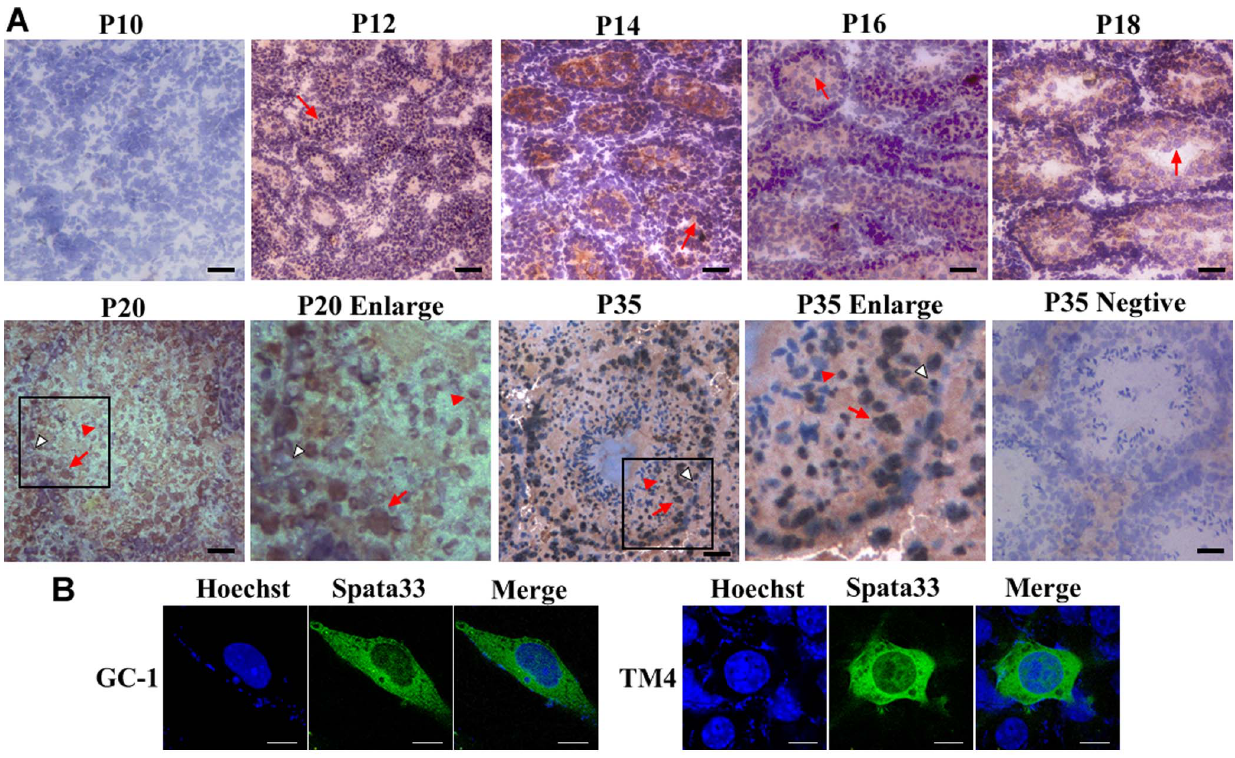
Figure 5. Immunostaining of Spata33 protein in the juvenile (aged 10–20 days) and mature testes (aged 35 days) using anti- Spata33 antibody (A), and subcellular localization of Spata33 protein in the GC-1 cells and TM4 cells (B). A). Spata33 was expressed mainly in the spermatogonia (white arrow heads), spermatocytes (red arrows) and round spermatids (red arrow heads). The signals were observed in both the cytosol and nuclei from P12-P35, whereas no signals were detected in P10. In controls, no positive signals were observed in P35 testis sections when Spata33 antibody was replaced by 1% normal rabbit serum. Nuclei were re-dyed with Hematoxylin (blue). Bars, 20 m m. B). GC-1 and TM4 cells were transfected with Spata33-GFP (green, Excitation 488 nm, Emission 507 nm) and stained with Hoechst (blue, Excitation 352 nm, Emission 461 nm) respectively. Spata33 is localized both in the nuclei and cytoplasm within GC-1 cells or TM4 cells. Bar, 10 m m.